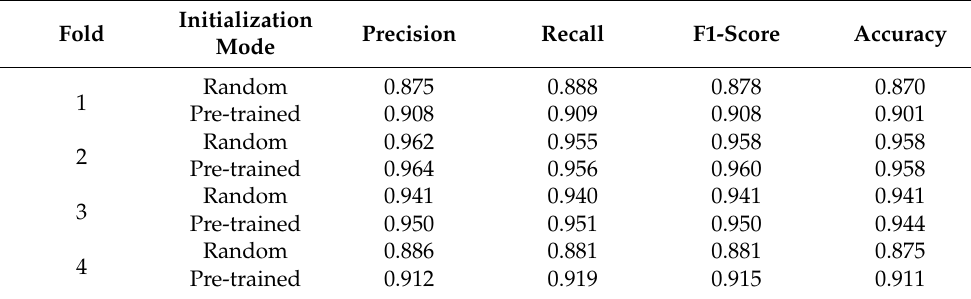
Table 6. Recognition results of model based transfer